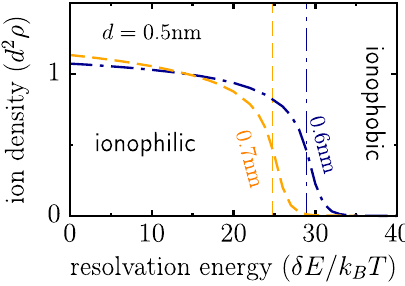
FIG. 2. An ion ’ s resolvation energy, δ E , determines the ion density (per surface area) inside nanopores at no applied voltage. At large δ E , ions prefer to stay outside the pores, and the pores are (nearly) free of ions; we term such pores ionophobic. In the opposite case of small or negative δ E , the pores are occupied by ions, and we call them ionophilic. The crossover between ¼ ionophilic and δ E crossover l ln ð 2 Þ =L , where l is the Bjerrum length and L the pore B B width (see text); δ E for two pore sizes ( L ¼ 0 . 6 nm and crossover L ¼ 0 . 7 nm) are shown by thin vertical lines. Pores with δ E close to δ E have moderate ion densities at zero applied crossover voltages, and we term them weakly ionophilic/ionophobic. The ion diameter is d ¼ 0 . 5 nm, and the Bjerrum length is ¼ 25 nm. This plot has been obtained by using the mean-field l B theory (see Appendix A).